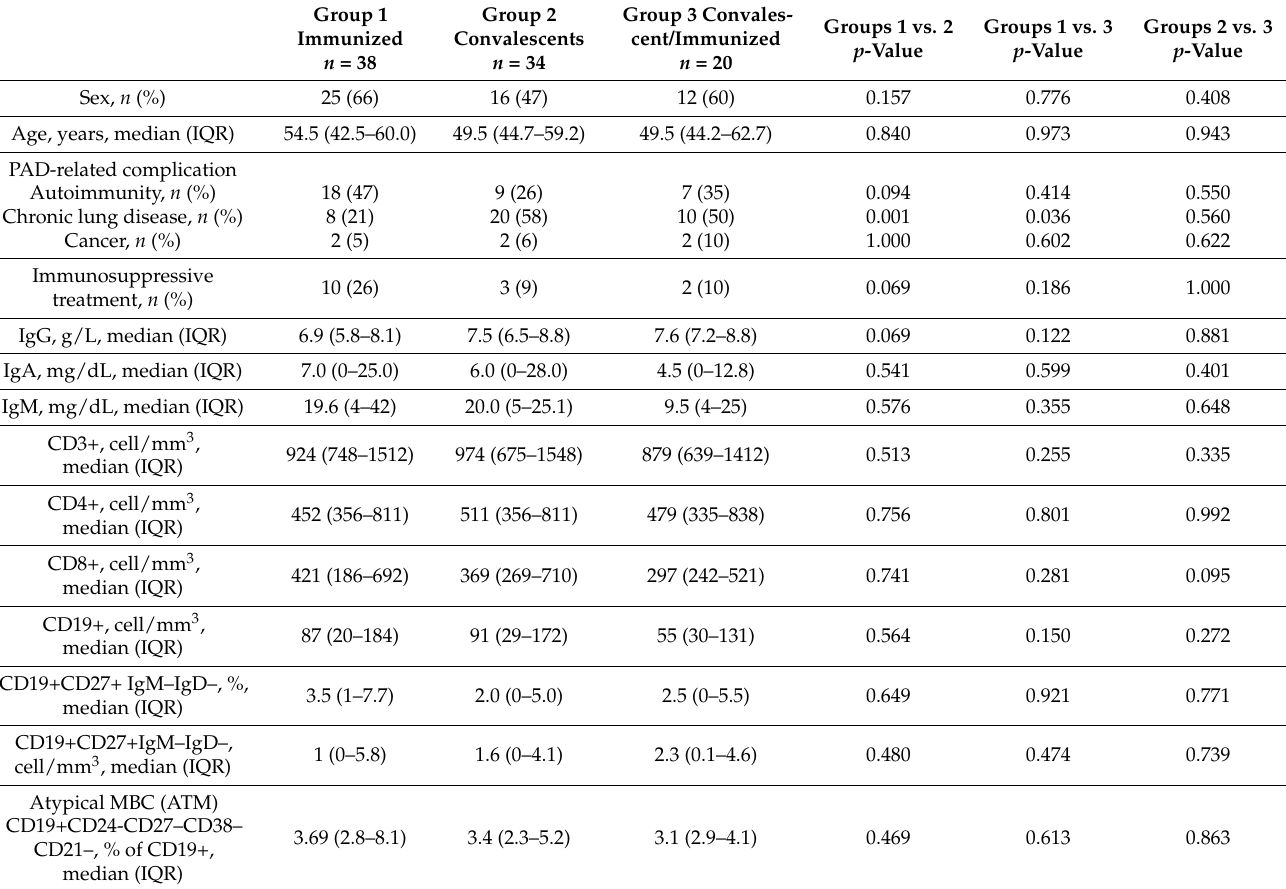
Table 1. Demographics, immunological, and primary antibody defect (PAD)-related characteristics in common variable immunodeficiency (CVID)